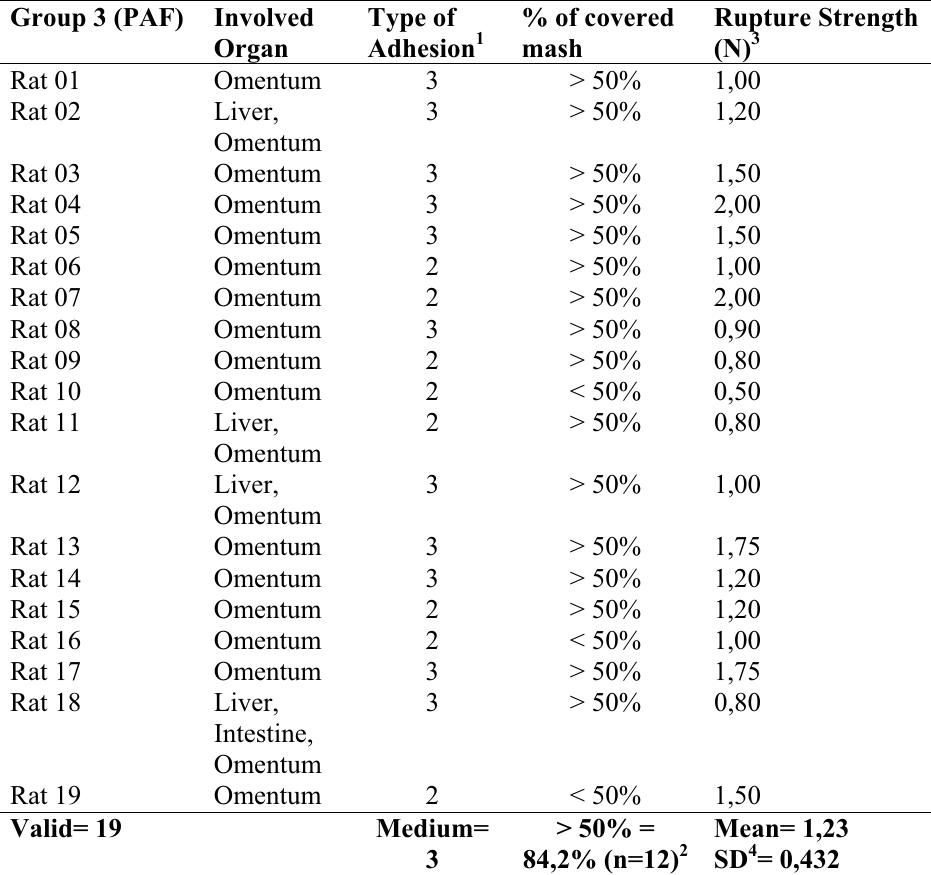
TABLE 4 - Results obtained for Group 3